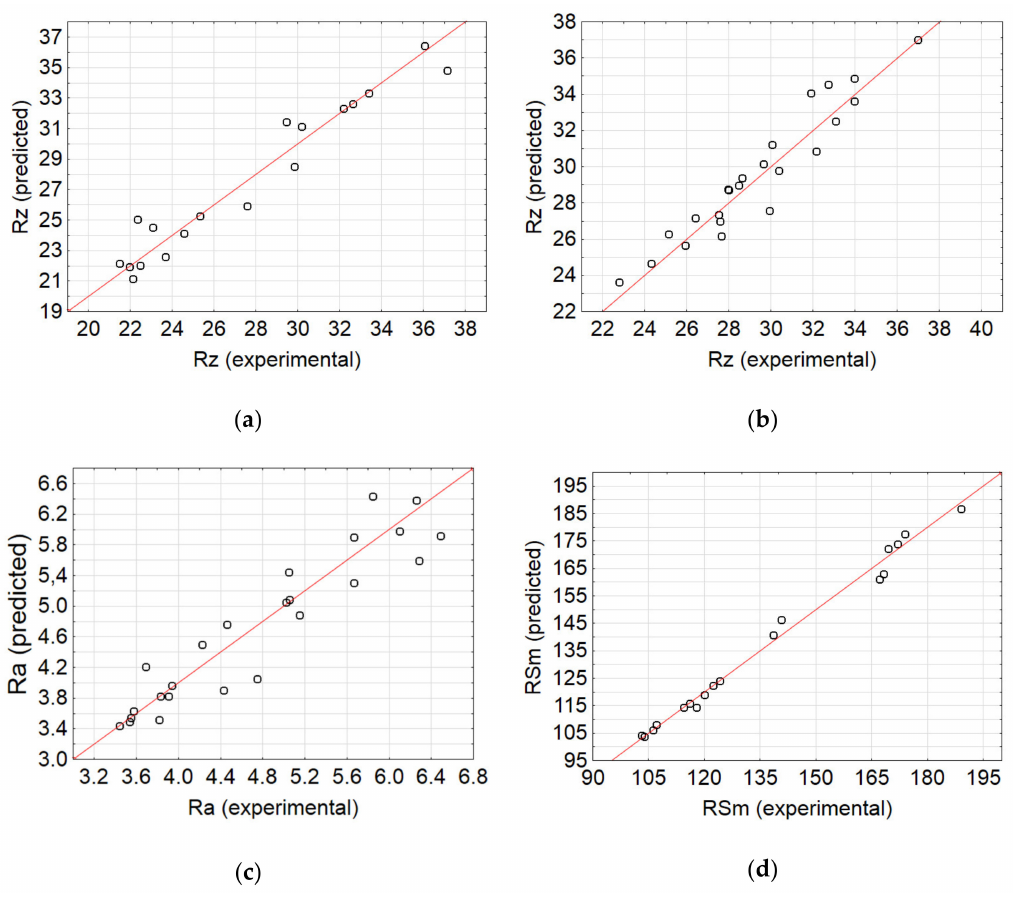
Figure 11. Comparison of artificial neural network (ANN) results with experimental measurements of surface roughness parameters Rz ( a ) AlSi21CuNi alloy (MLP 3-2-1) and ( b ) AlSi10Mg alloy (MLP 3-14-1); ( c ) surface roughness parameters Ra AlSi21CuNi alloy (RBF 3-8-1); and ( d ) surface roughness parameters RSm AlSi21CuNi alloy (RBF